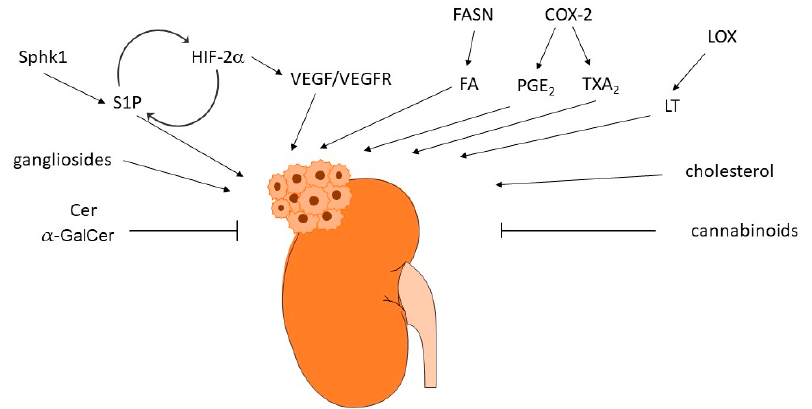
Figure 4. Summarizing scheme of bioactive lipids regulating renal cell carcinoma. Abbreviations: Cer, ceramide; COX-2, cyclooxygenase 2; FA, free fatty acid; FASN, fatty acid synthase; α -GalCer, galactosylceramide; HIF, hypoxia inducible factor; LOX, lipoxygenase; LT, leukotriene; PGE 2 , prostaglandin E 2 ; S1P, sphingosine 1-phosphate; Sphk1, sphingosine kinase 1; TXA 2 , thromboxane A 2 ; VEGF, vascular endothelium growth factor; VEGFR, VEGF receptor.